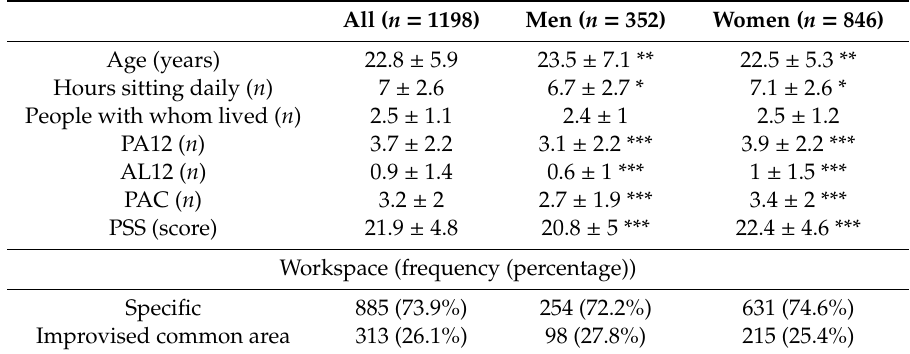
Table 1. Descriptive statistics of the sample (data provided average ± standard